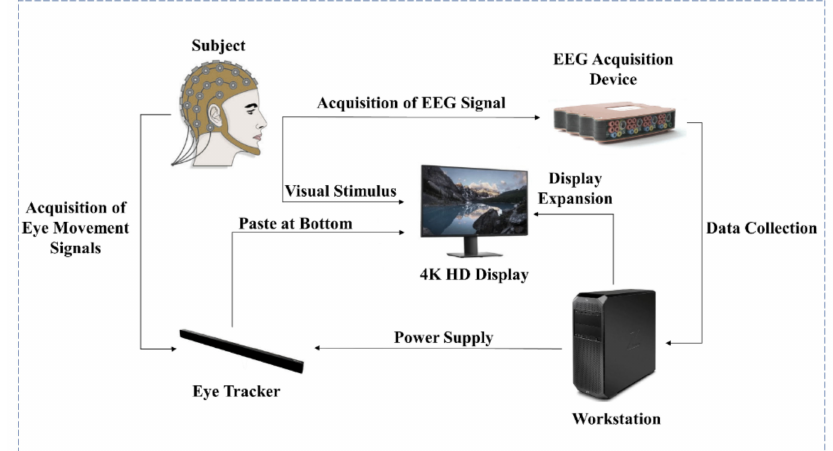
Figure 1. Experimental system.